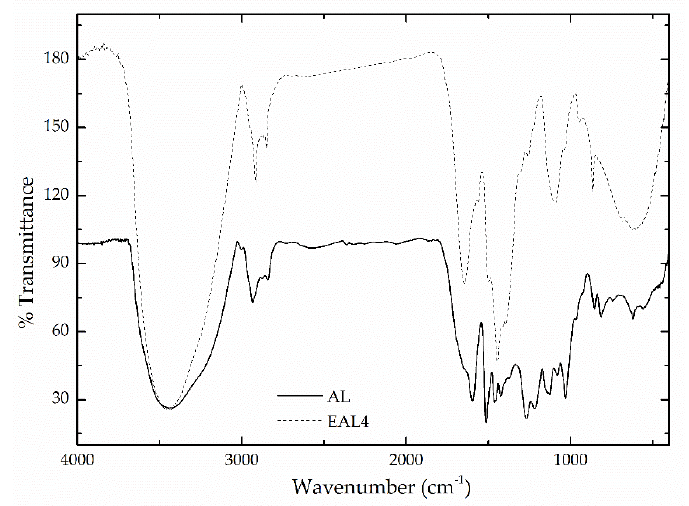
Figure 1. FTIR spectra for the original alkali lignin and a selected epoxide-modified lignin (EAL4).